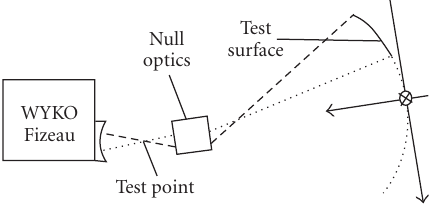
Figure 2: Setup for testing the o ff -axis